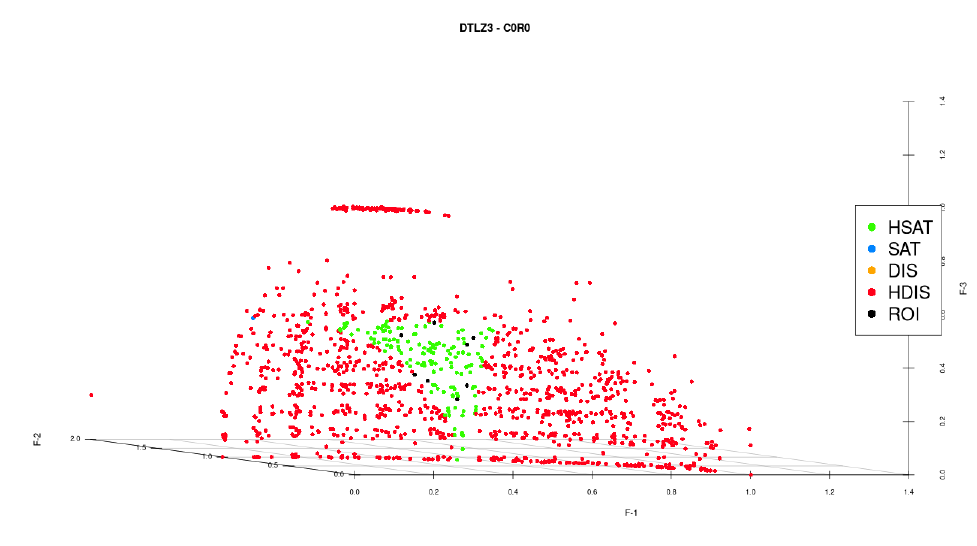
Figure 2. Non-dominated NSGA-III(C0R0) solutions of the DTLZ3 problem.